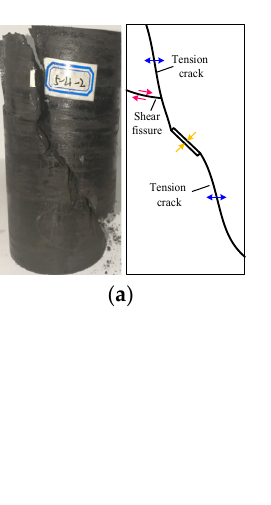
Figure 6. A 0. 3 MPa confining pressure with different numbers of prefabricated cracks in coal spec- imen failure mode and its sketch. ( a ) M-0.3-1; ( b ) M-0.3-2; ( c ) M-0.3-3; ( d ) M-0.3-4.